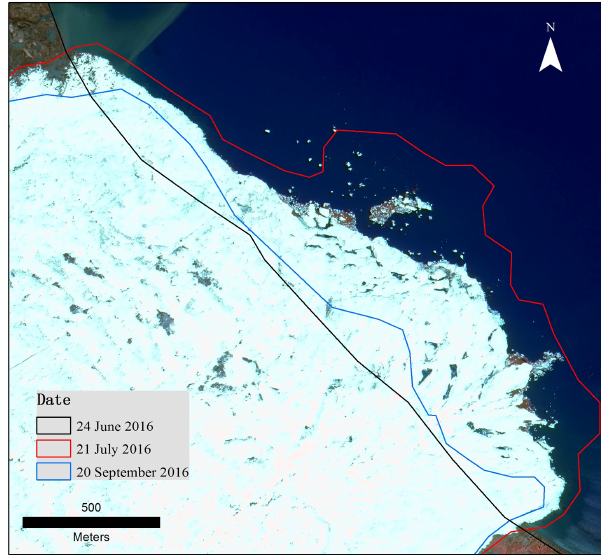
Figure 4. The extent of the intruding ice into Aru Co. Gaofen-2 satellite image (1m resolution) is used to indicate the extent of the intruding ice into Aru Co and the floating ice over the lake surface on 25 July